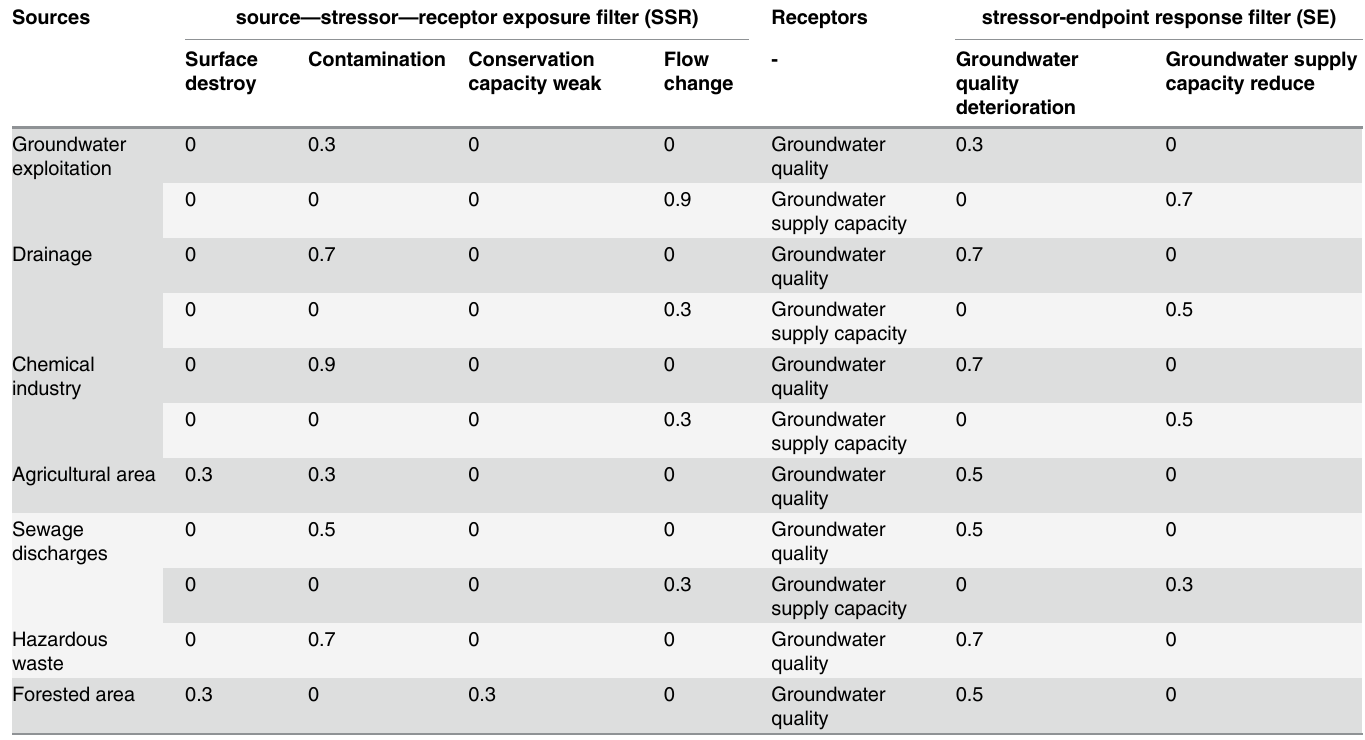
Table 2. Exposure and response filters of risk Sources, Receptors, and